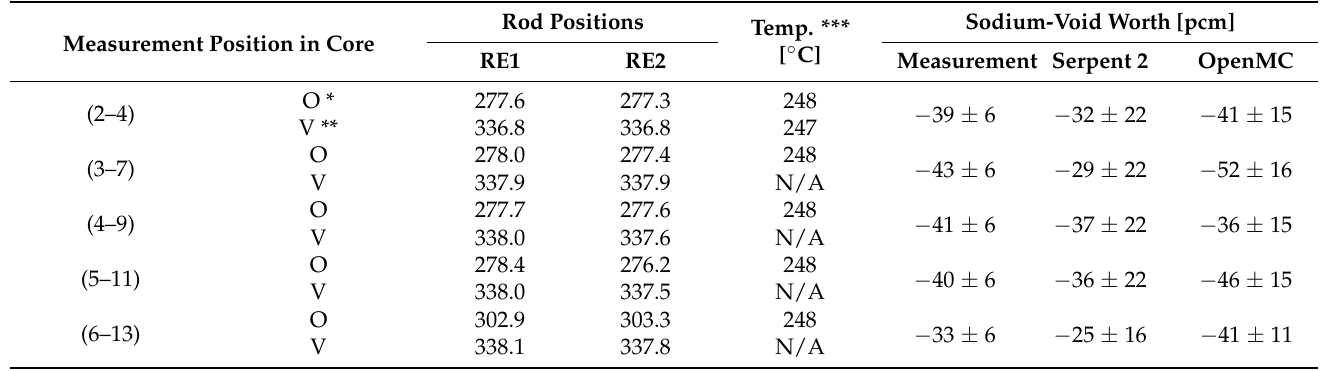
Table 6. Results of void worth.